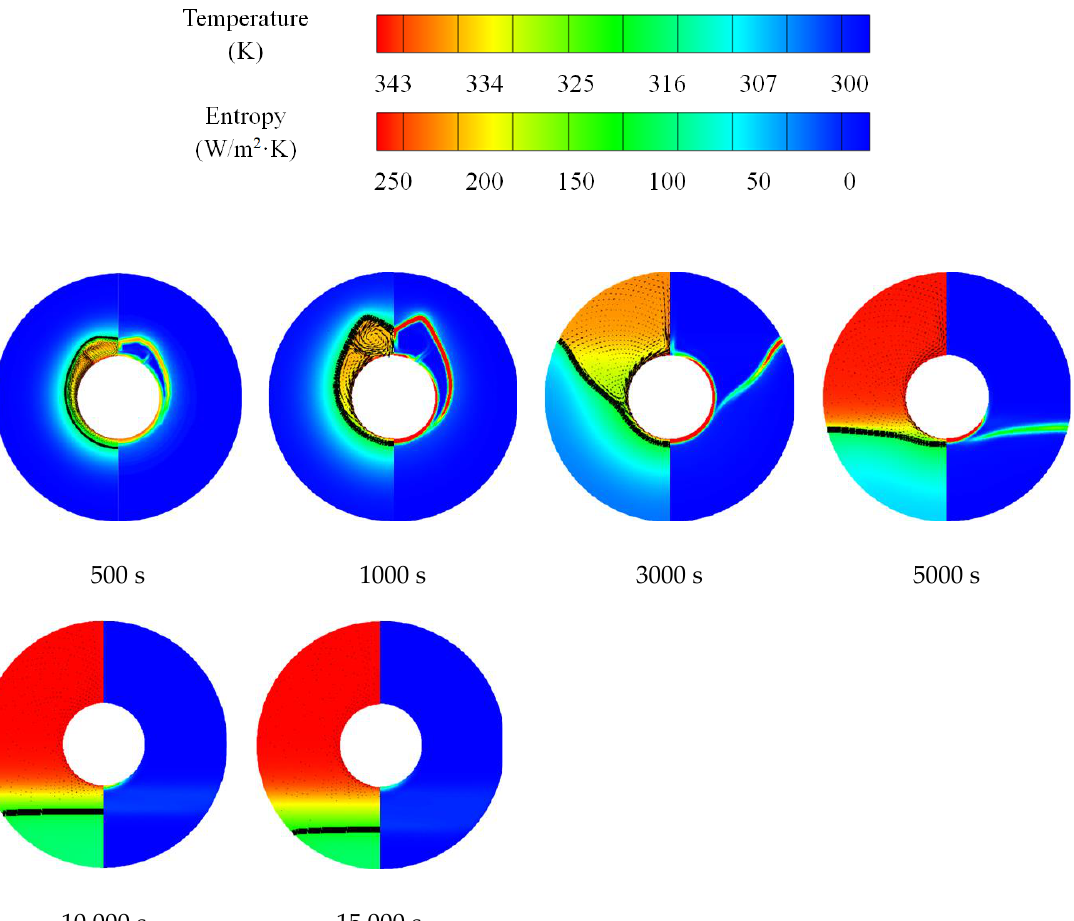
Figure 4. Temperature distribution, liquid – solid interface (left side) and local entropy generation (right side) for no-fin case in melting.